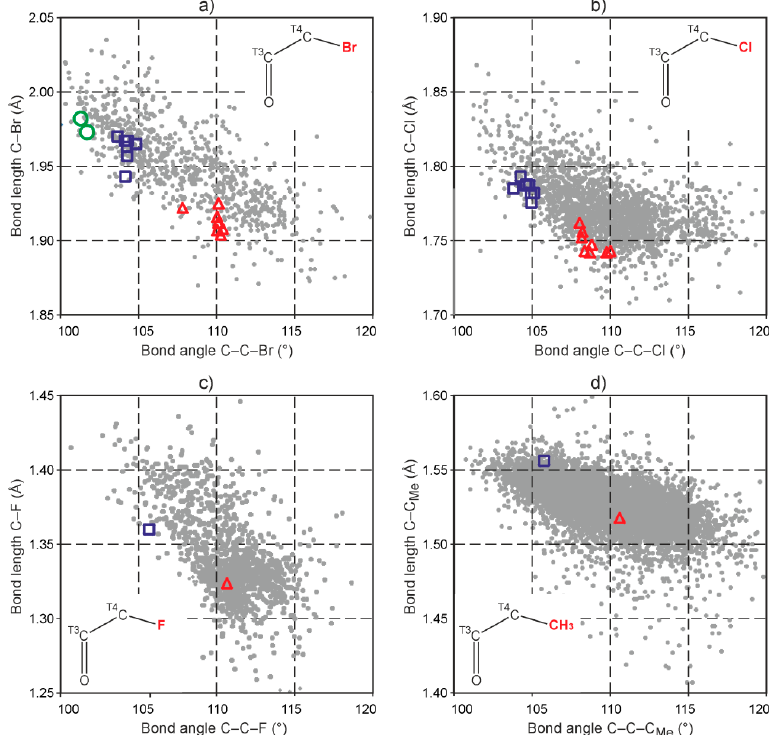
Figure 8. Bond lengths C–X plotted against bond angles C–C–X (gray dots) for structure fragments O=C(sp 2 )–C(sp 3 )–X with X = Br ( a ); Cl ( b ); F ( c ) and CH 3 ( d ) identified in CSD surveys. Red triangles and blue squares represent the parameters of the equatorial C5–X and axial C5–X ′ bonds, respectively, listed in Table 4. Green circles in ( a ) represent data points for the axial C5–Br ring substituent bonds of the two C5-endo envelope rings in the molecule of 2 .